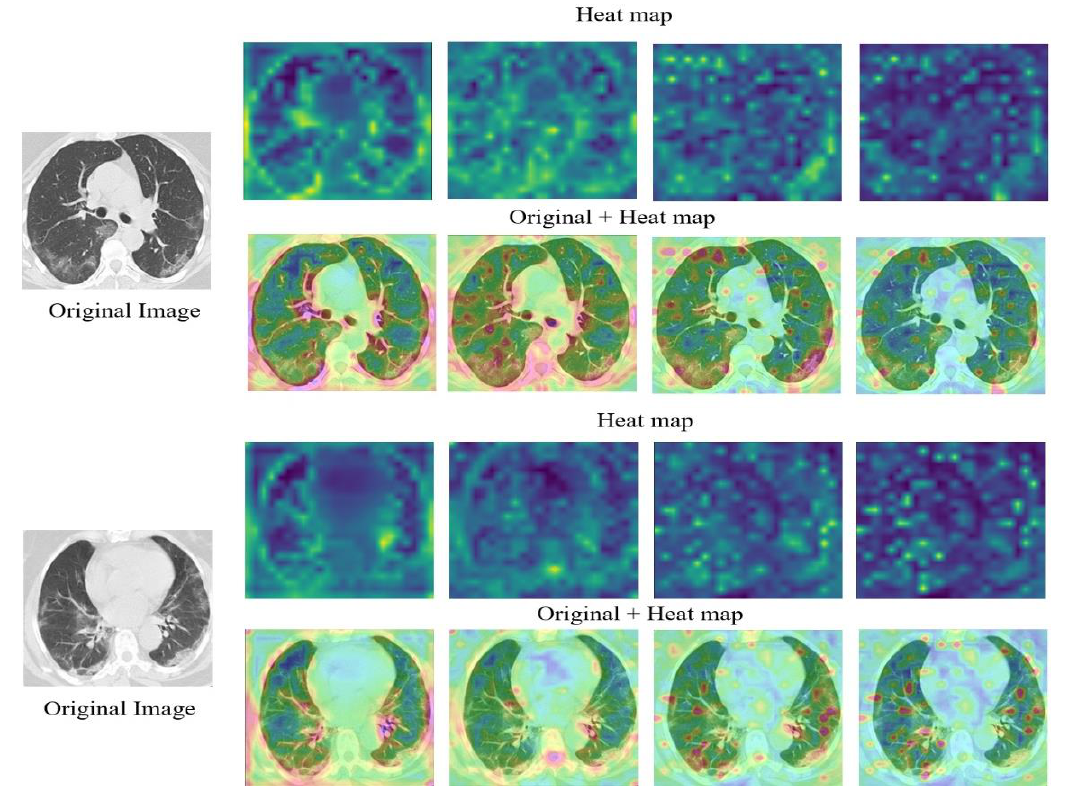
Figure 6. Heat maps of CT images of COVID-19 cases. Table 6. Classification results (expressed as a percent) obtained on the CT dataset with a split of